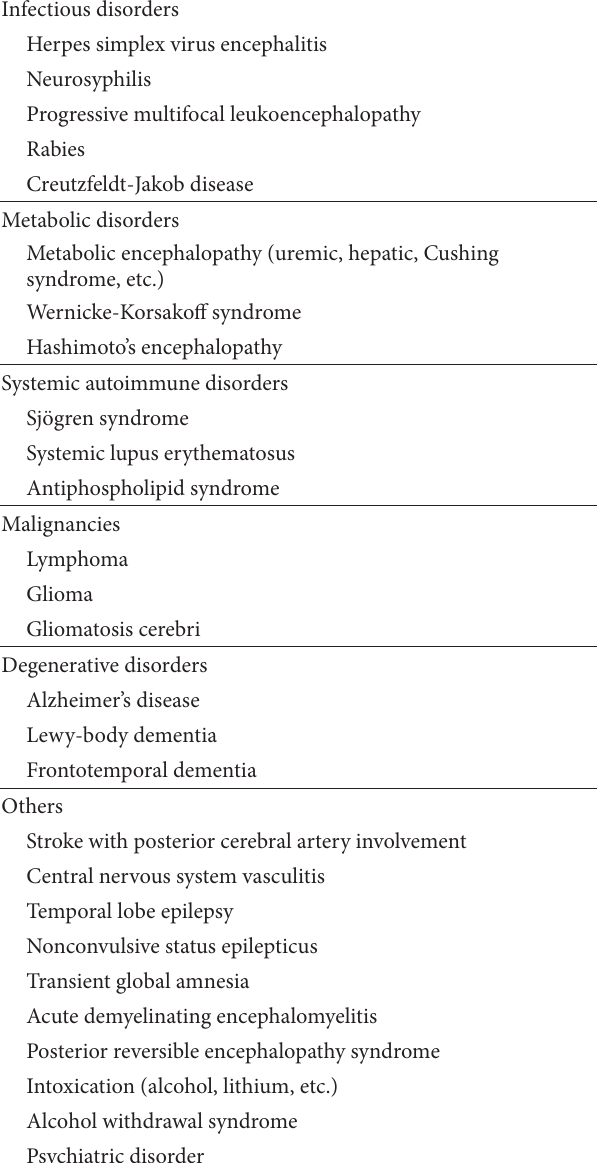
Table 3: Differential diagnoses of limbic encephalitis. Infectious disorders Herpes simplex virus